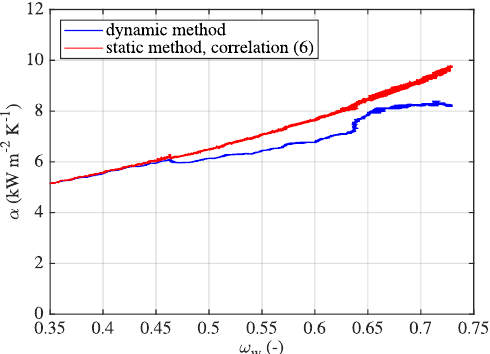
Figure 12. The dynamic method—effect of composition on HTC and comparison with correlation